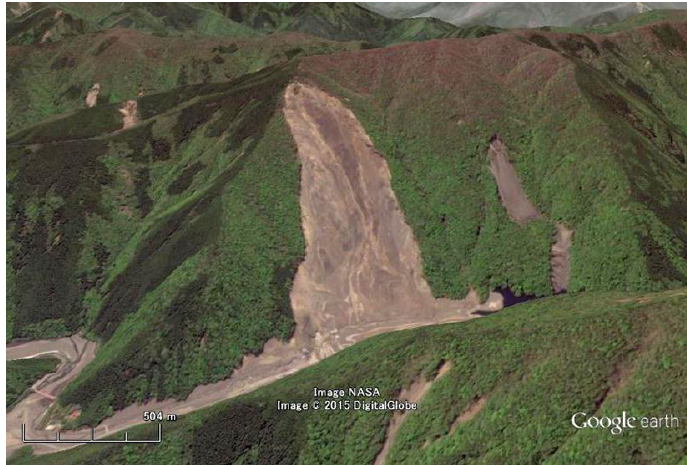
Figure 3. An optical image of a landslide within the images of Figures 2 and 4. The acquisition date of this optical image is 4 May 2014, which is close to that of the PolSAR data in Figures 2 and 4. It is found that there is no vegetation in the landslide area, while slopes in the vicinity are covered with